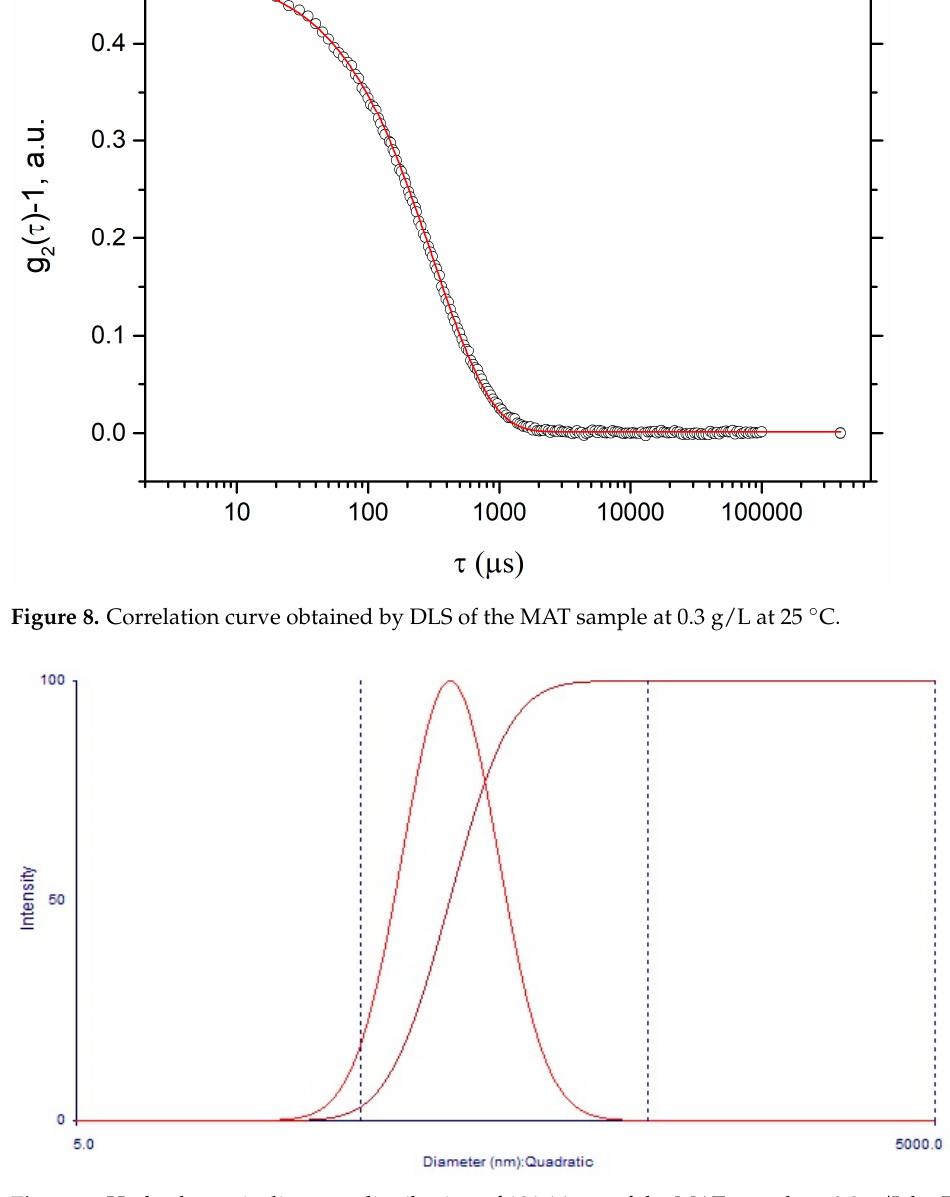
Figure 9. Hydrodynamic diameter distribution of 101.14 nm of the MAT sample at 0.3 g/L by DLS. Transmission Electron Microscopy (TEM): The morphology observed in the micro- graphs shows spherical and cylindrical shapes (Figure 10). The average particle radius value found is 31.81 nm obtained using ImageJ 1.51m9 software from Wayne Rasband, National Institute of Health (500 particles analyzed), presented in Figure 11. The values TEM using a JEOL JEM-2010F Field Emission apparatus (Akishima-shi, Japan) operating at 200 keV on a 200-mesh carbon on a copper grid (Ted Pella) followed